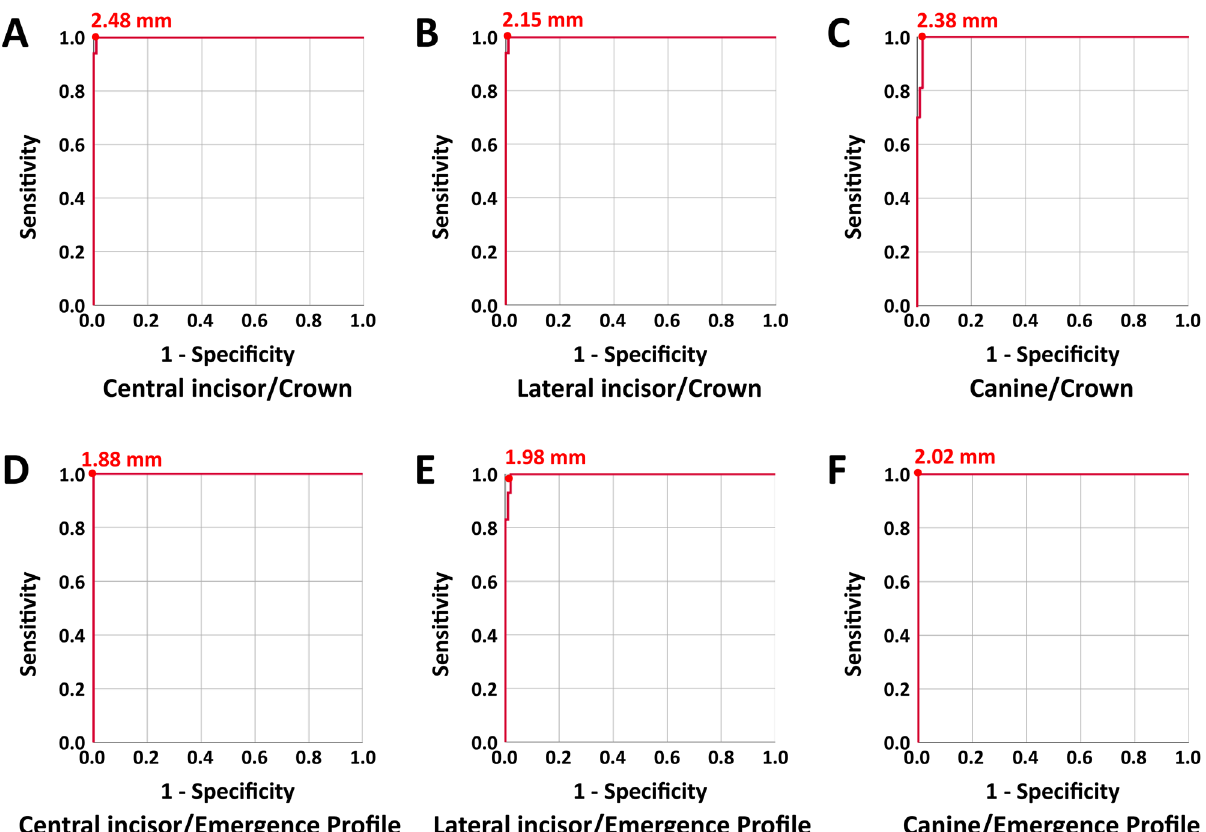
Figure 1. ROC curves for 3D HD thresholds for pair matching central incisors ( A , crown; D , emergence profile), lateral incisors ( B , crown; E , emergence profile), and canines ( C , crown; F , emergence profile). The smallest HD (mm) for 100% sensitivity was